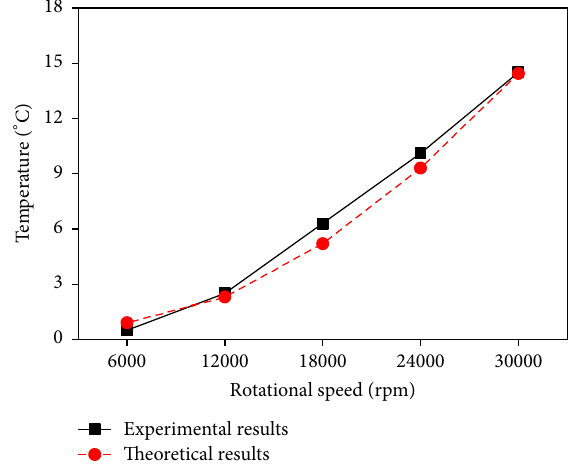
Figure 3: Exit temperature rise versus rotational speed at a supply pressure of 2.5